Question: Express in one sentence what the figure is showing.
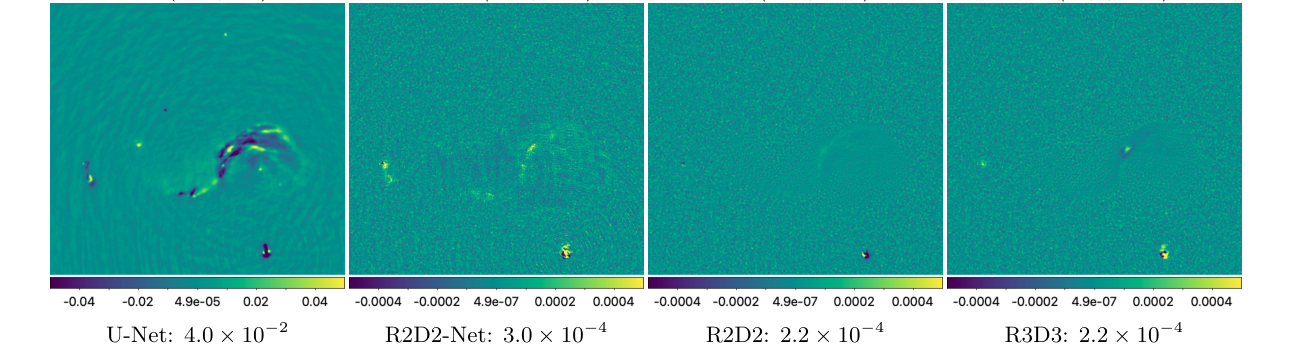
Answer: Experiment IV: reconstructions results of the radio galaxy Messier 106. The first and third rows show the ground truth image and the estimated images obtained by the imaging algorithms (logarithmic scale). The second and fourth row shows the dirty image and the corresponding residual dirty images (linear scale). For R3D3, we showcase the results of its realization with J = 6 layers in its R2D2-Net components. Values of (SNR, logSNR) are reported below estimated images. The σres. values are indicated below the residual dirty images.